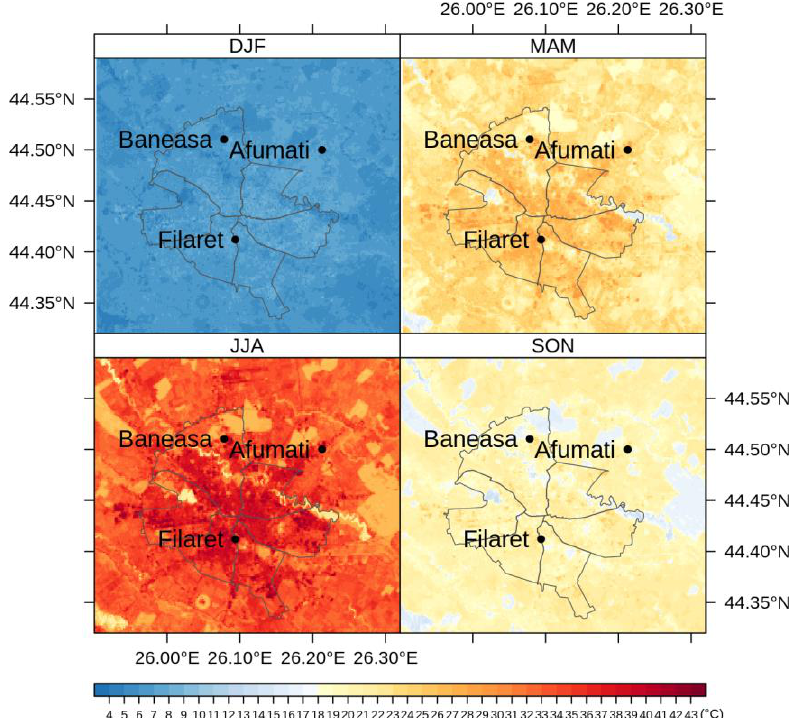
Figure 9. Average seasonal LST values (°C) over Bucharest retrieved from Landsat 8 imagery (2013–2018).